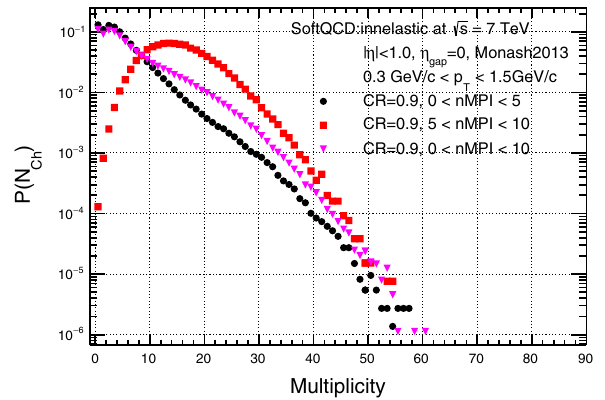
Fig. 4 Multiplicity distributions for p + p event classes according to different number of MPI ranges